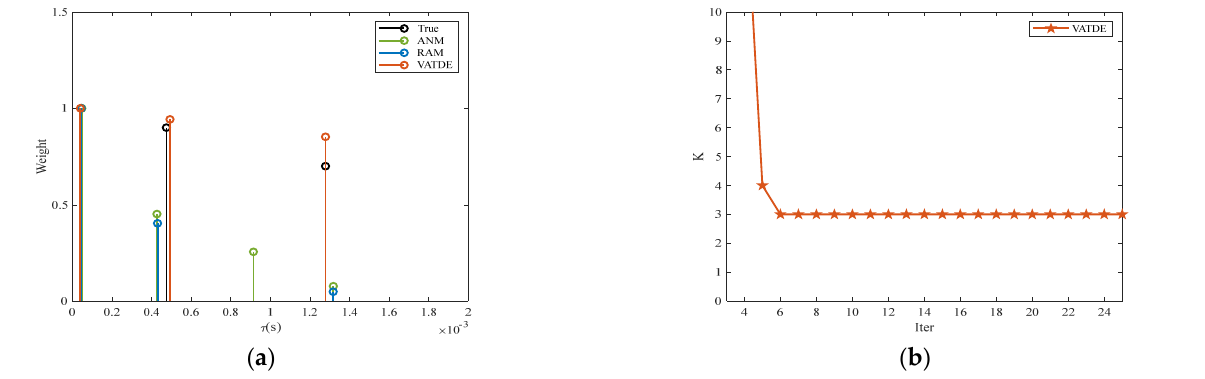
( b ) Figure 2. Phase reconstruction performance of different algorithms in the case of SNR 10 dB. ( a ) Original signal phase and noisy, ( b ) reconstruction results of signal phase by different algorithms. Second, assuming the presence of a multipath influence, there were two time delays between the received signals of the two sensors, which signifies that there will be three time delays in the cross-power spectrum. In this paper, the magnitudes of the three time delays were set to